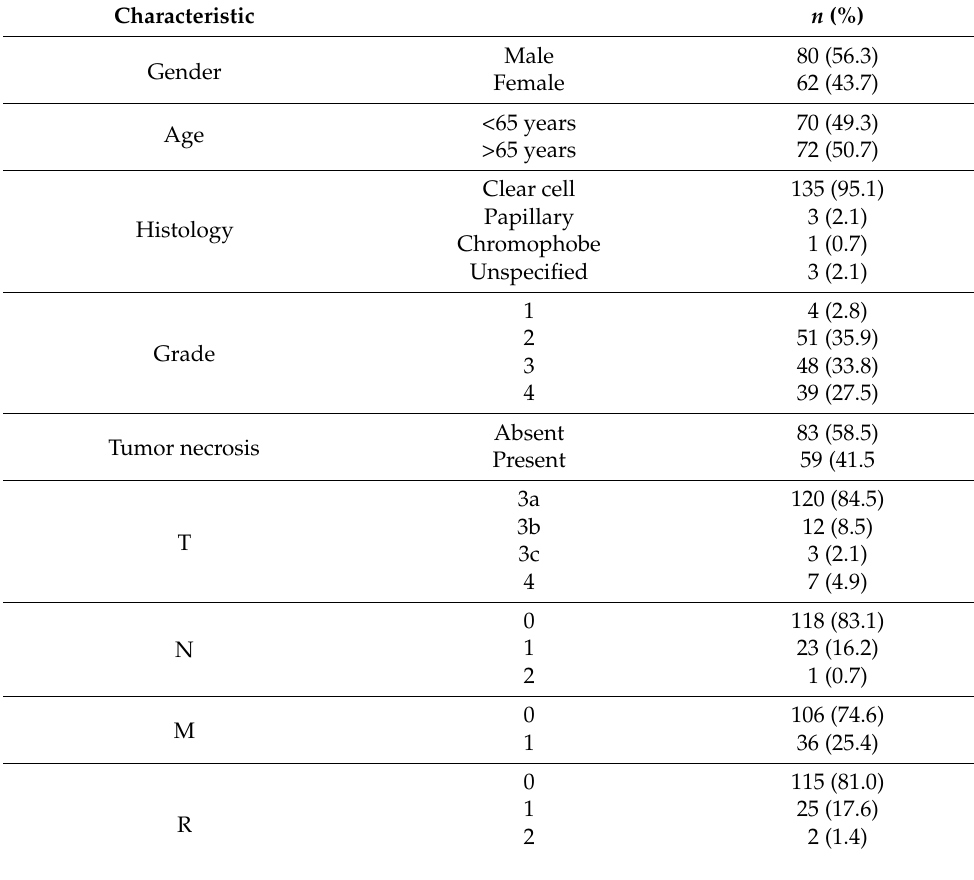
Table 1. Basic characteristics of the study group. Abbreviations: LOH: length of hospitalization; TKI: tyrosine kinase inhibitors; MAB: monoclonal